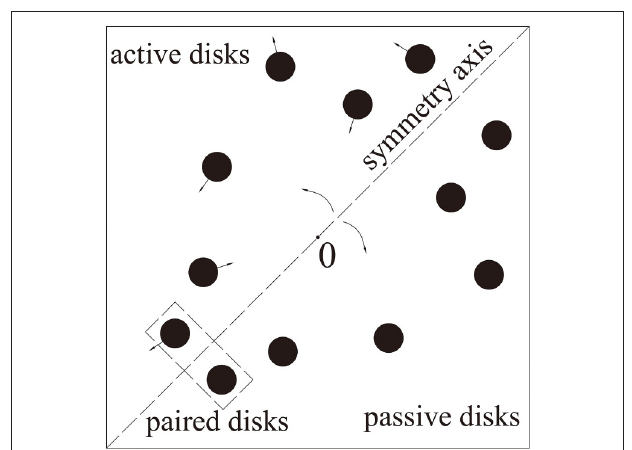
FIGURE 1 | Stimuli in SMOT. The invisible axis rotated around the center of the presentation window. The starting positions and directions of the active disks were random. Each active disk was symmetrical with a passive disk. Coordinates of the passive disks were determined by coordinates of the active disks and the axis of symmetry. The disks bounced off each other, the edges of the presentation window and the invisible axis of